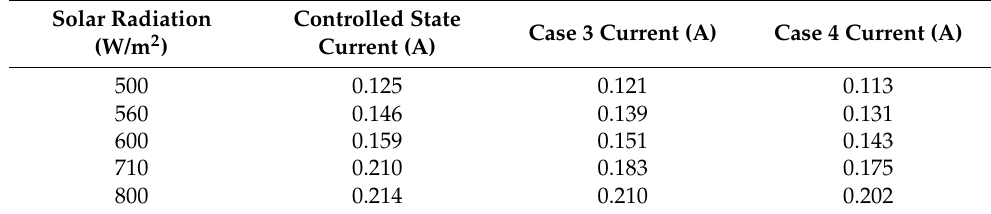
Table 6. Comparison of the current output of the PV miniature system for the three conditions at different solar